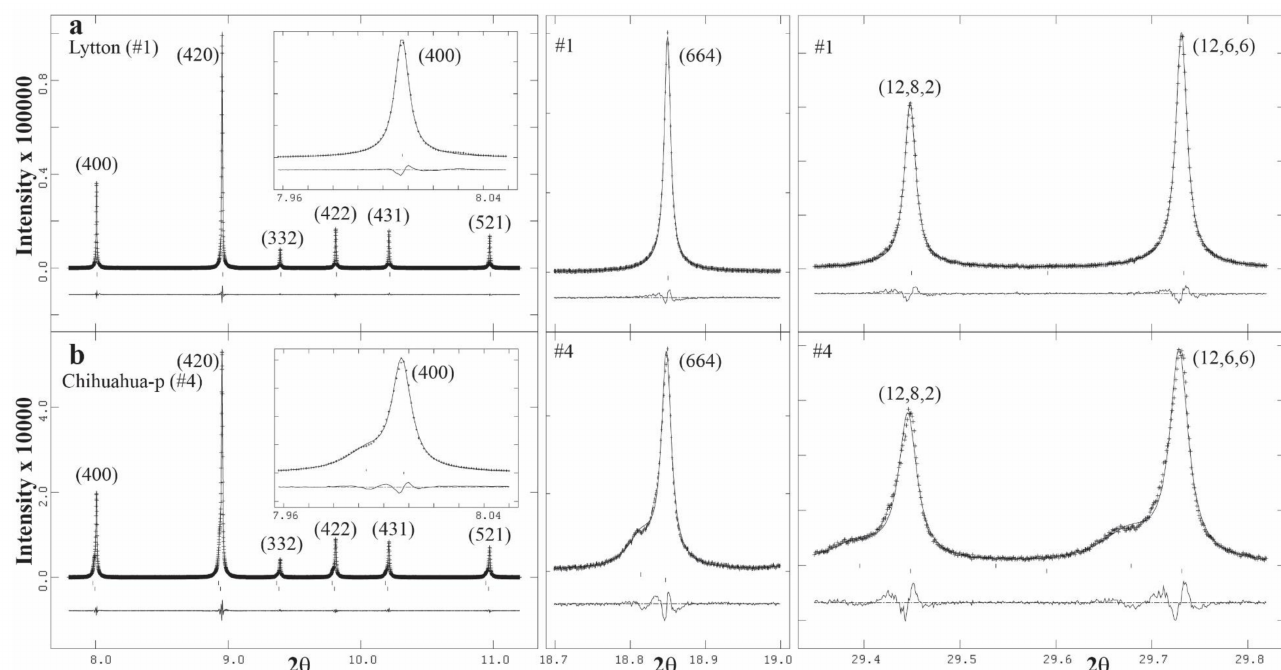
Figure 15. Expanded scale for the same reflections from ( a ) Lytton (sample-1) and ( b ) Chihuahua-p (sample-4) samples. Each reflection peak in ( b ) is clearly split into two because of the two different cubic phases, whereas those for the single cubic phase in ( a ) are sharp, narrow, and symmetrical.